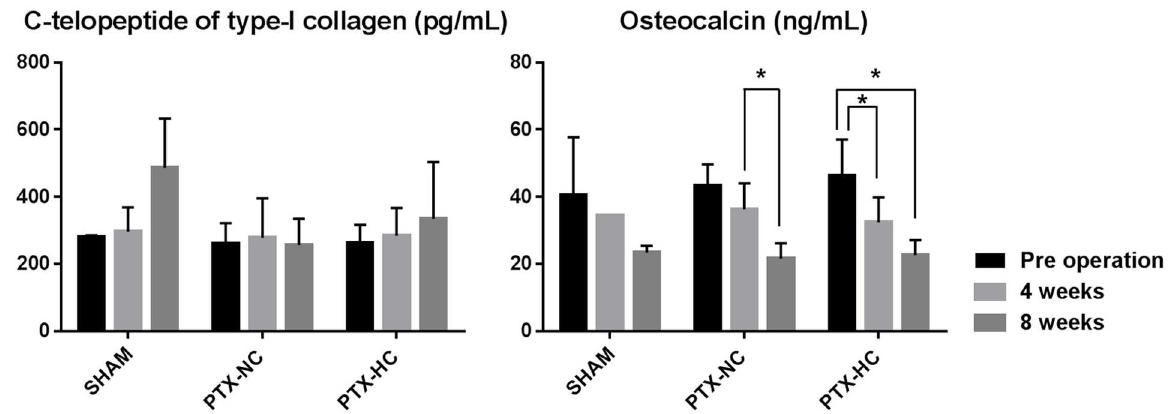
Fig 6. Bone turnover markers. C-Telopeptide of type I collagenlevels increasedin the SHAM group but not the PTX groups. Osteocalcin levels decreasedin all three groups.